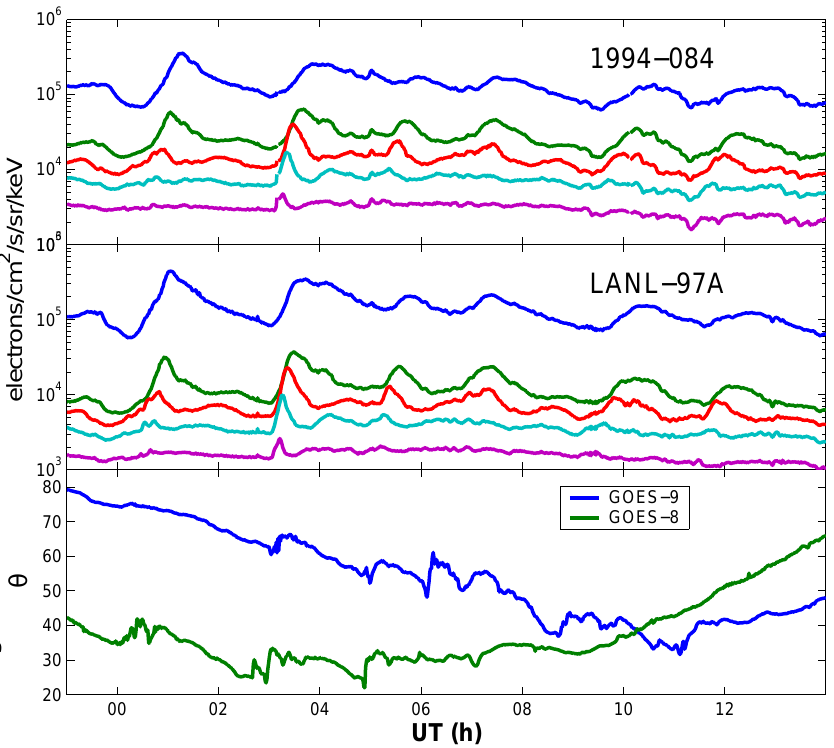
Fig. 6. Data from the LANL and GOES satellites on the 11 May 1998. The electron flux (LANL) is provided in seven channels: 50–75keV (blue), 75–105keV (green), 105–150keV (red), 150–225keV (cyan) and 225–315keV (magenta). The magnetic inclination is the angle of the local magnetic field to the equatorial plane; the larger the value of θ the more dipole-like the field is. The series of flux enhancements with dispersed energy signatures indicate periodic particle injections during